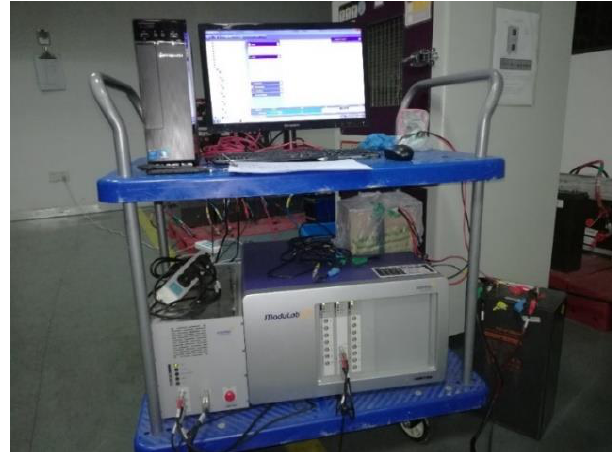
Figure 7. Experimental platform.